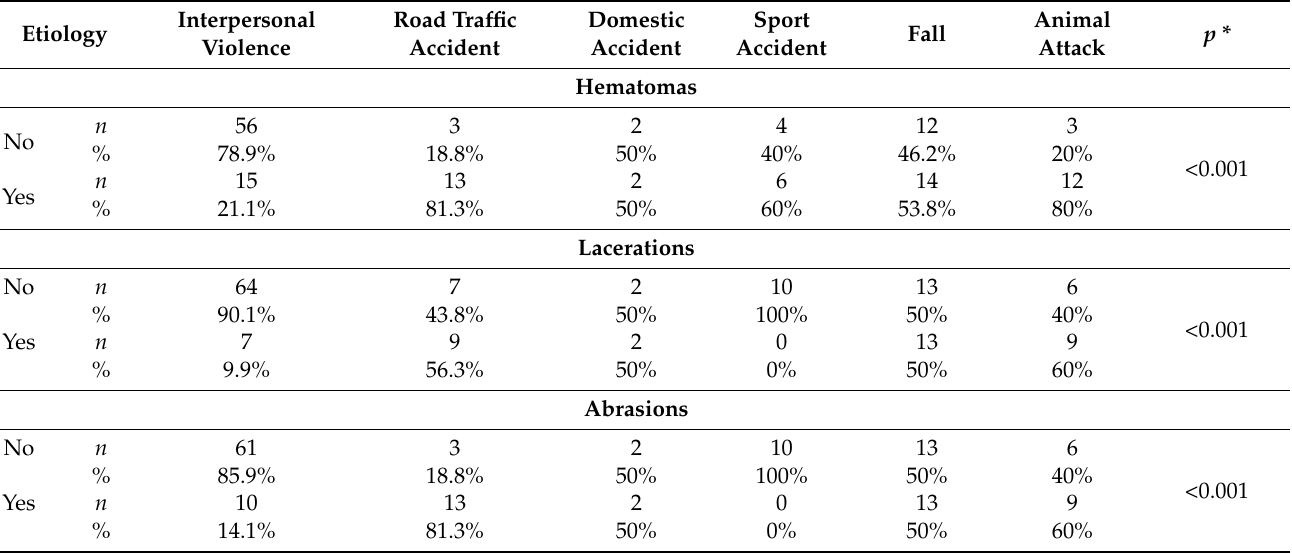
Table 2. Distribution of the pediatric patients according to the presence of soft tissue associated lesions and etiology of